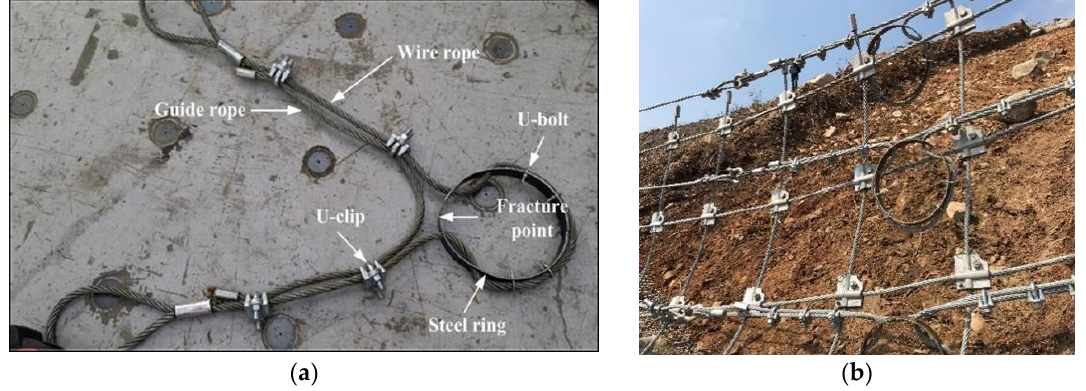
Figure 2. Depiction of the elements of brake frame and installation in the system, ( a ) components of brake frame; and ( b ) brake frame installed in the